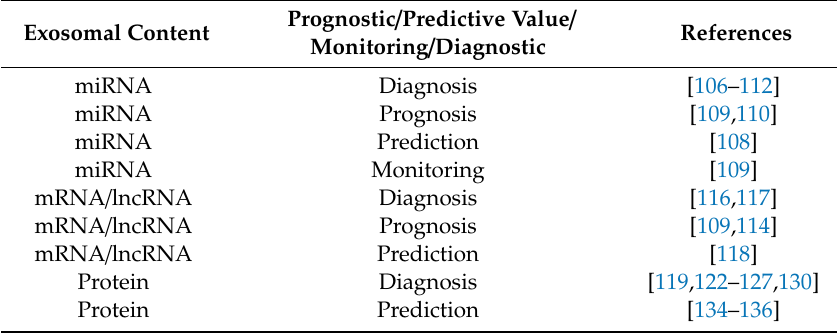
Table 3. Examples of studies suggesting the potential of circulating exosomal RNA and proteins as liquid biopsies in breast